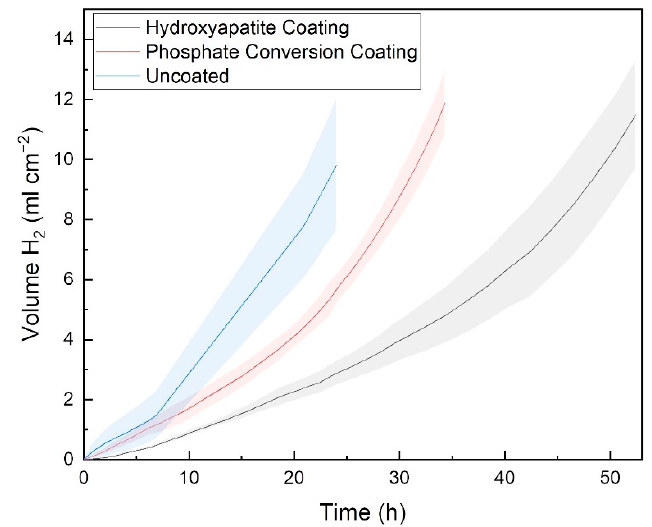
Figure 9. Hydrogen evolution comparison between uncoated, hydroxyapatite-coated, and phosphoric conversion coated porous Mg-Zn-Zr scaffolds. The shaded regions represent the standard deviation of the respective hydrogen evolution collection data. Table 3. Tabulated average hydrogen evolution rate of uncoated and coated porous Mg-Zn-Zr sam- ples with hydroxyapatite and phosphate conversion coating in PBS maintained at 37 °C.